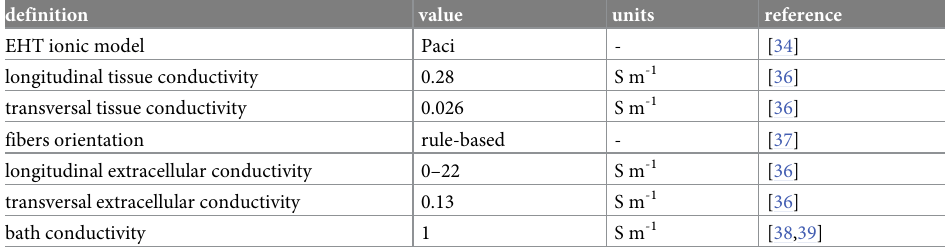
Table 2. Model quantities kept fixed in all simulations: conductivity of the internal and external bath areas, ionic model used for the EHT, conductivities and fiber orientations for the host myocardium.